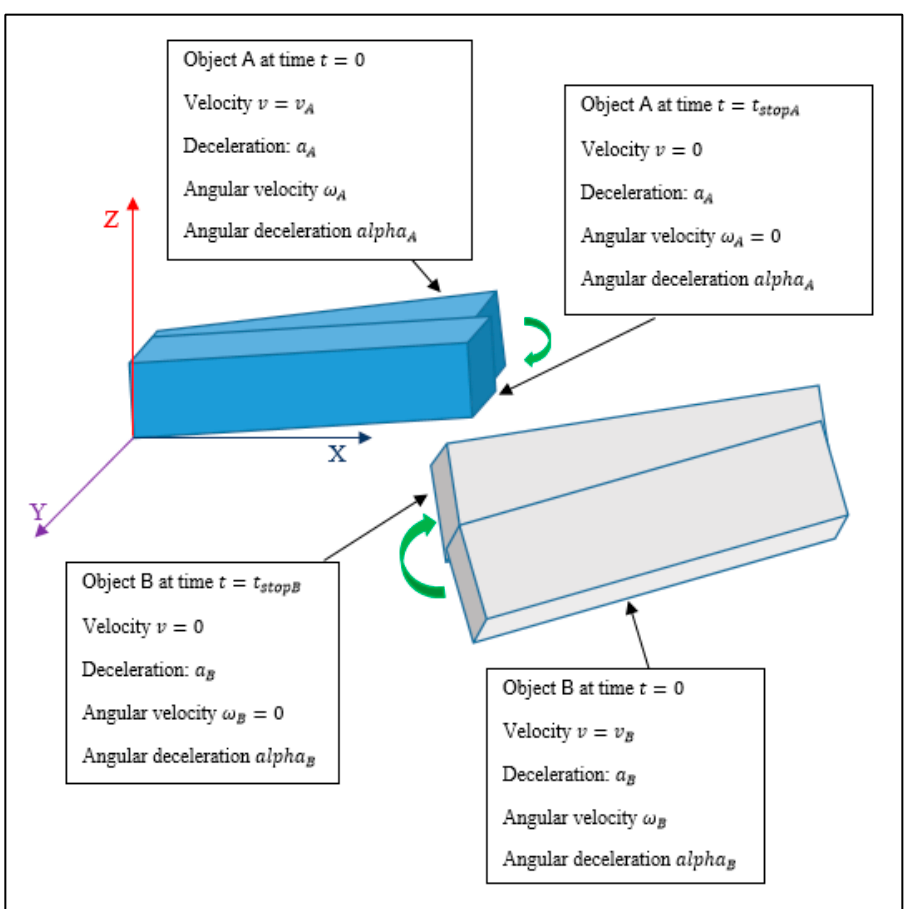
Figure 8. Oriented anti-collision box of objects.